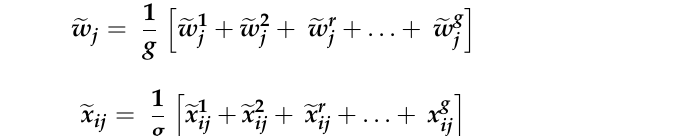
2. Constructing the fuzzy decision matrix of the criteria ( (cid:101) D ) and the alternatives ( (cid:101) W ), as shown in Equations (12) and (13):